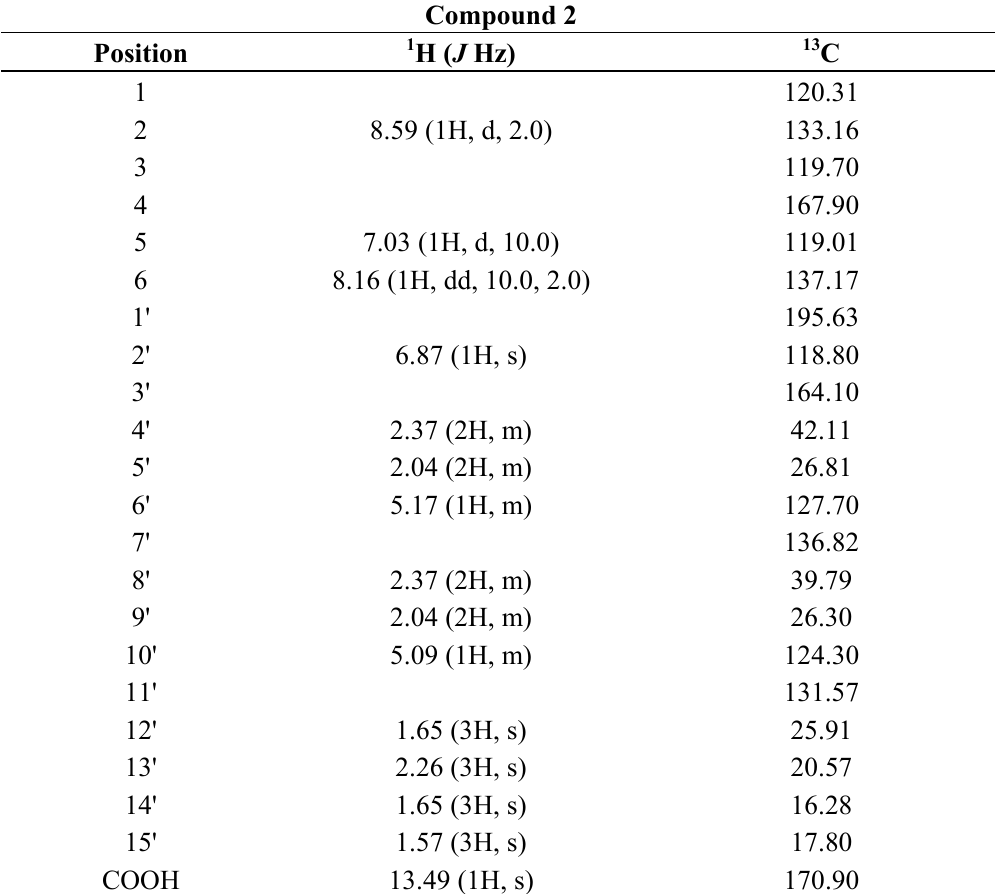
Table 1. 1 H (200 MHz) and 13 C (50 MHz) NMR data of compound 2 . Compound 2